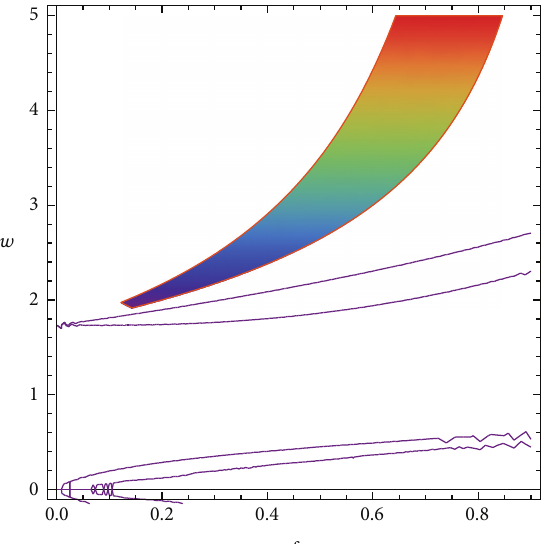
Figure 8: Region 𝑅 𝑇 is given by the colored portion of the graph and the constraints 𝐶(𝑠,𝑤) = 0 , 𝐶 ∗ (𝑠,𝑤) = 0 are given by the purple lines. There is no intersection between the CC region and the